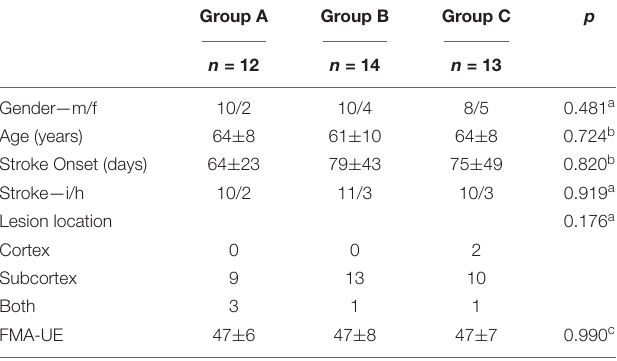
TABLE 1 | Demographic and clinical